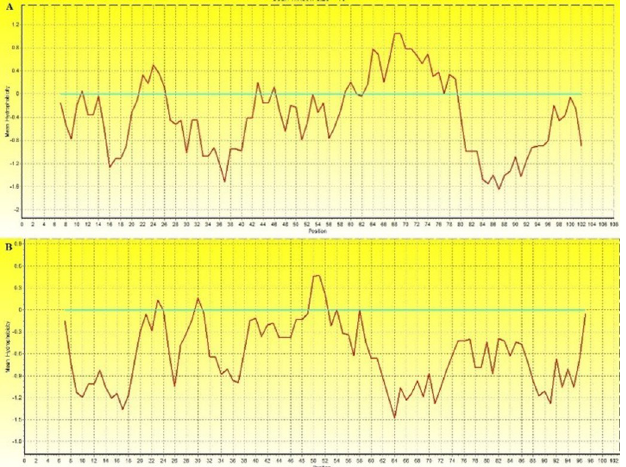
Fig 1. Kyte and Doolittle Hydrophobicity plot derived from the MAP2191 (A) and FAP-P (B) conserved amino acid sequences. The hydrophilic residues are below the blue line, and the hydrophobic residues are shown above the blue